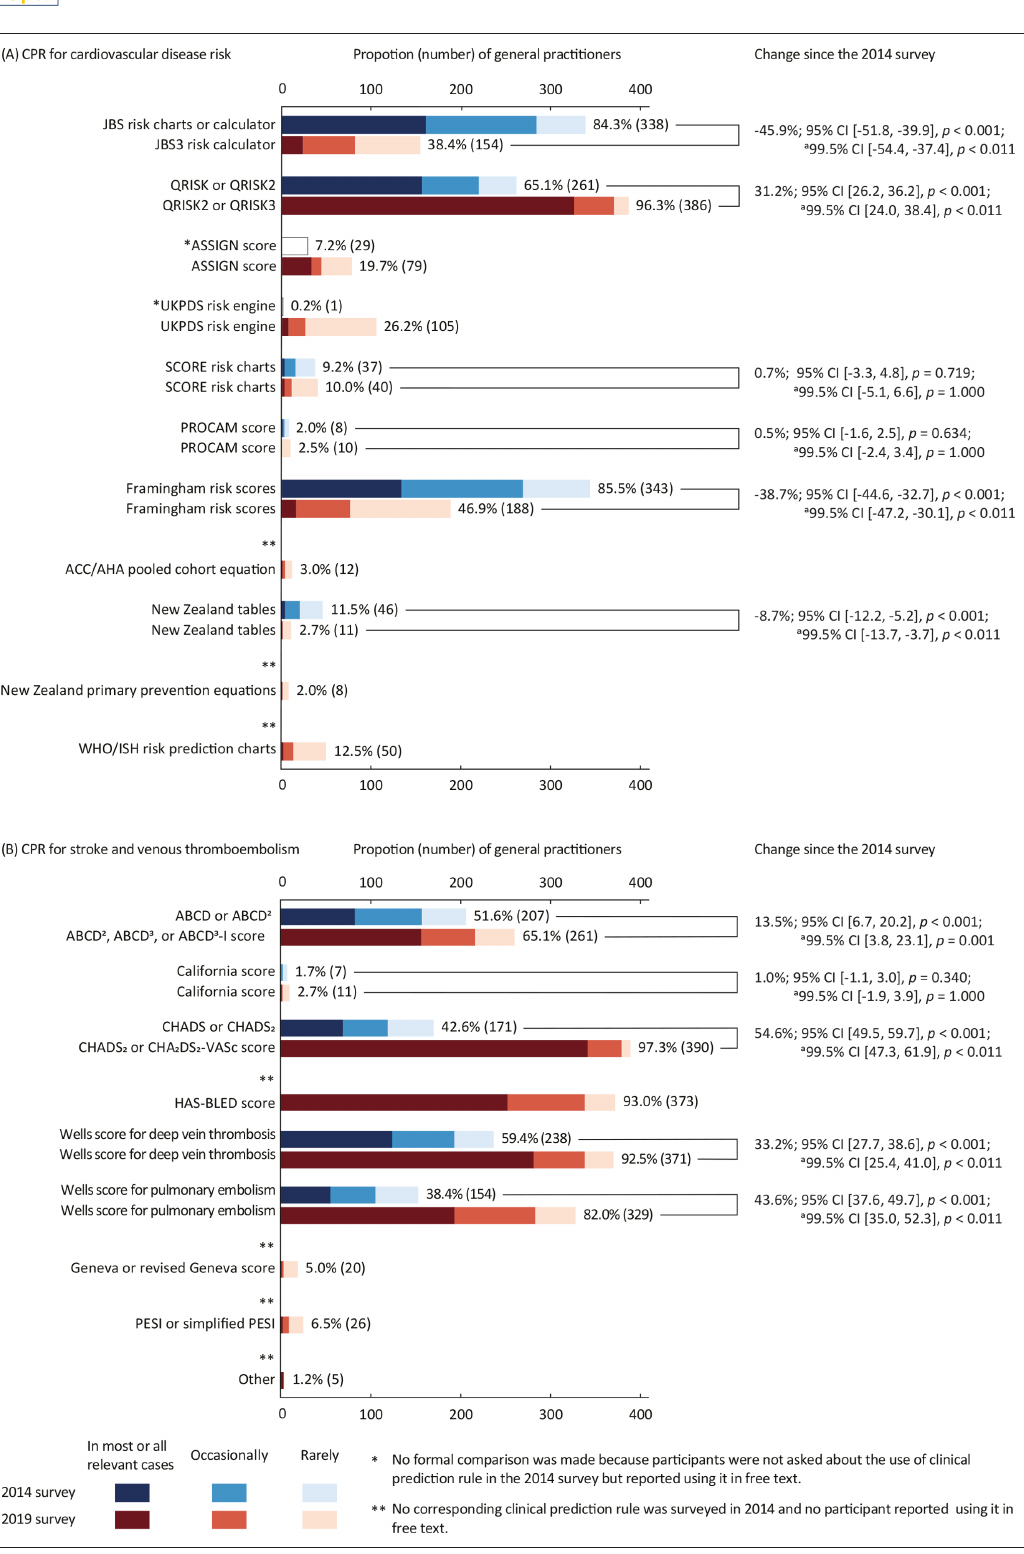
Figure 1 The proportion of GPs using clinical prediction rules for A) cardiovascular disease risk and B) venous thromboembolism in the 2014 and current survey. a Confidence interval (CI) and P value adjusted using the Bonferroni